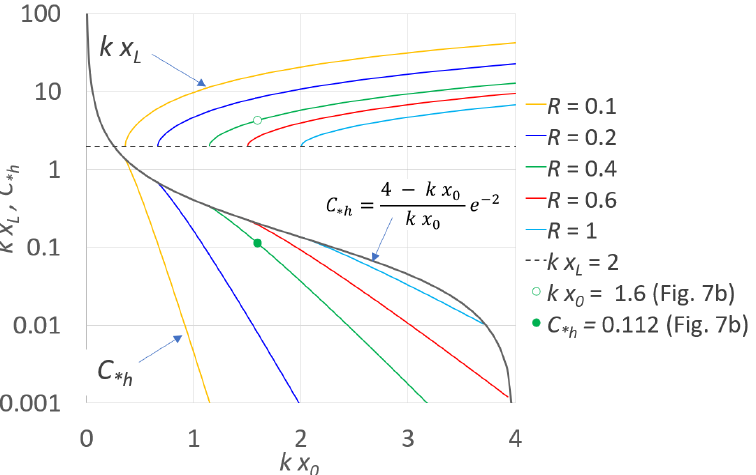
Figure 6. Relationship between k x L and C *h versus k x 0 for different return ratios R . The limiting k x L ( k x L = 2), and C *h conditions (Equations (38)) are also indicated.